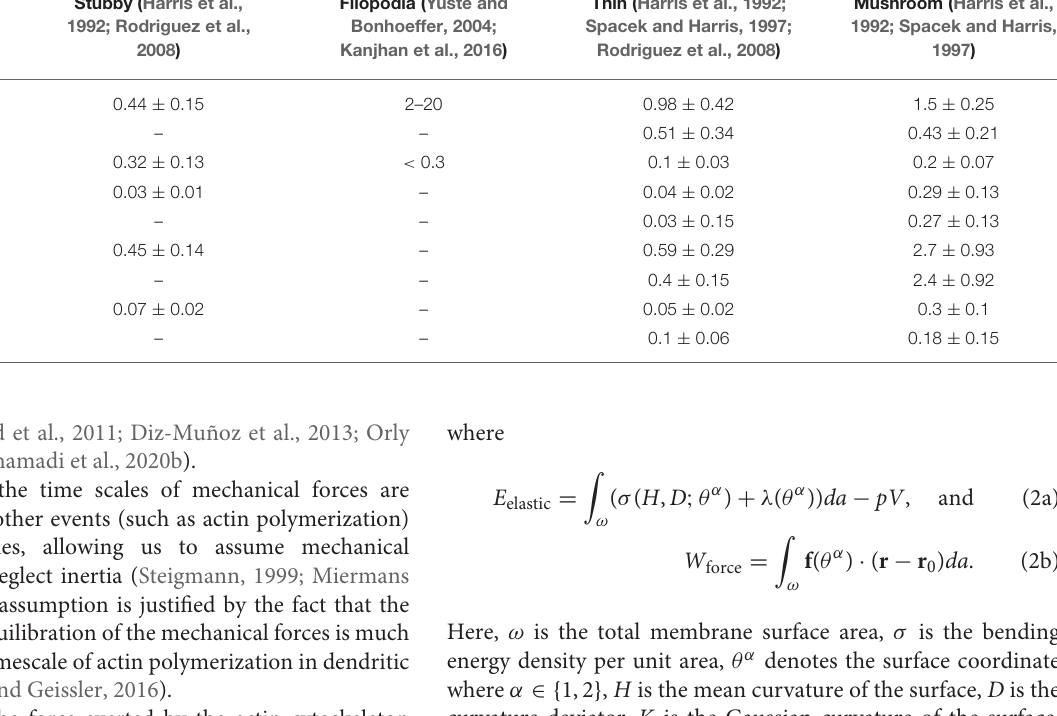
TABLE 1 | Dimensions of different spine shapes compiled from the literature. Stubby (Harris et al., 1992; Rodriguez et